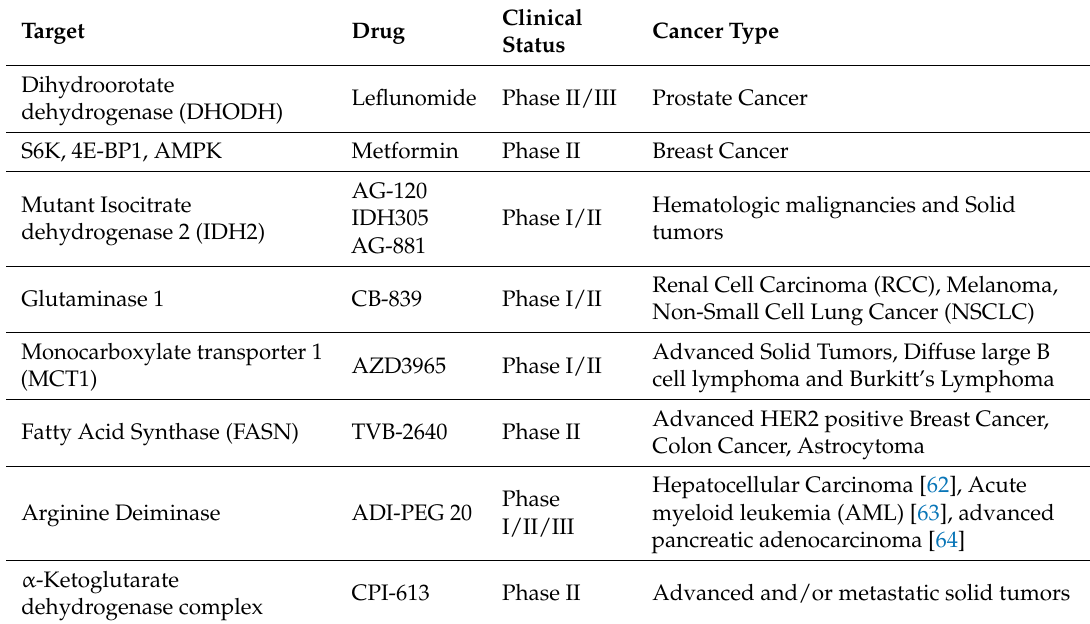
Table 2. Drugs targeting cancer metabolism currently in clinical